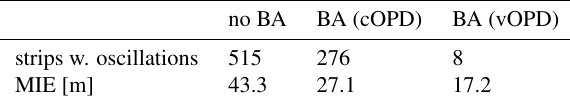
Table 2: Results of 515 HRSC image strips for different bundle adjustment (BA) runs